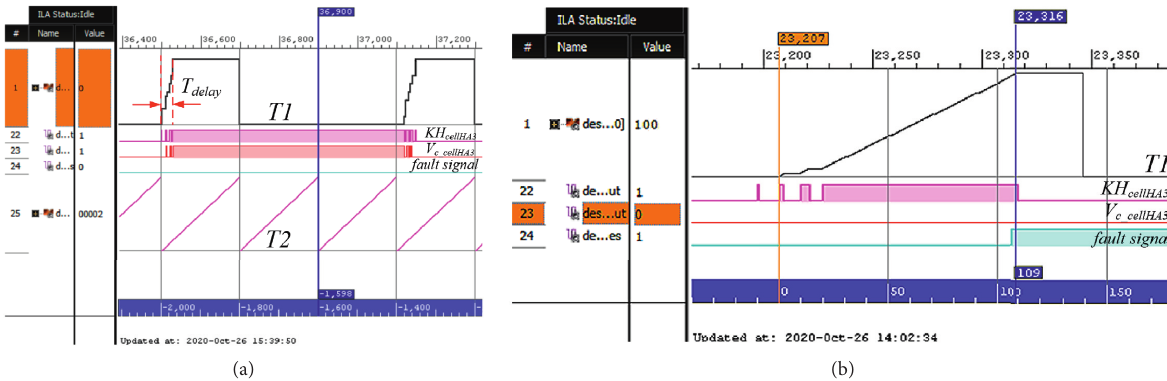
cellHA3 and V c_cellHA3 of cell HA3 on FPGA in (a) normal operation and (b) faulty